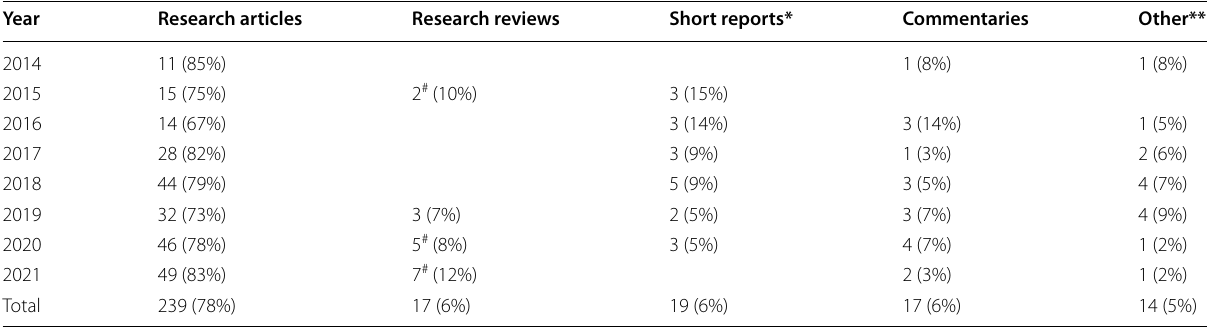
Table 1 Number (percentage) of publications of each type by